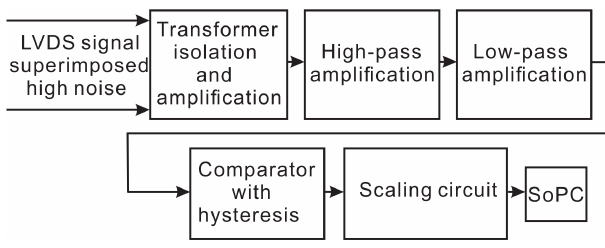
Figure 4. Physical layer structure of buoy receiving side.